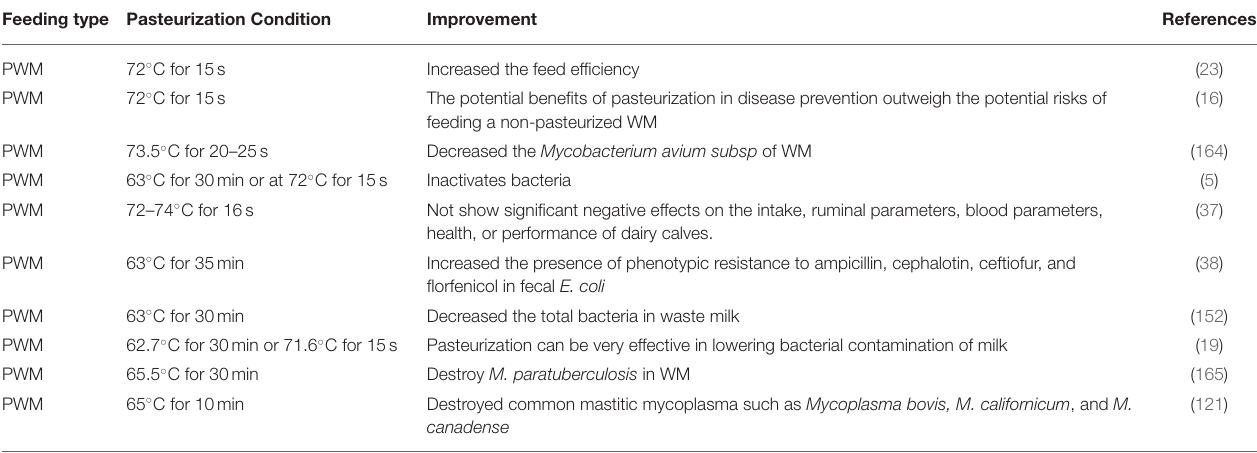
TABLE 5 | Pasteurization condition and improvement of raw